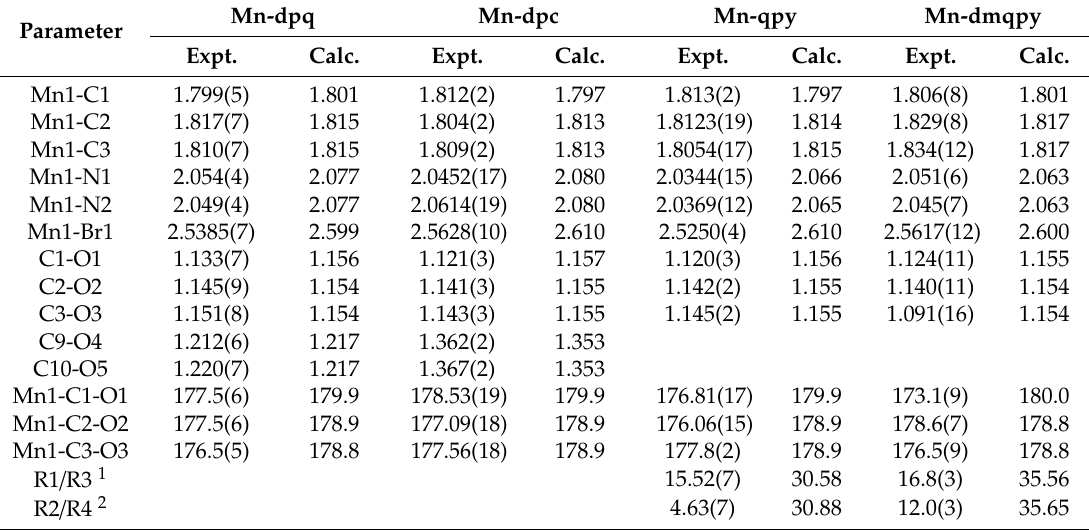
Table 2. Selected bond lengths (Å) and angles ( ◦ ) for the Mn(I) complexes.